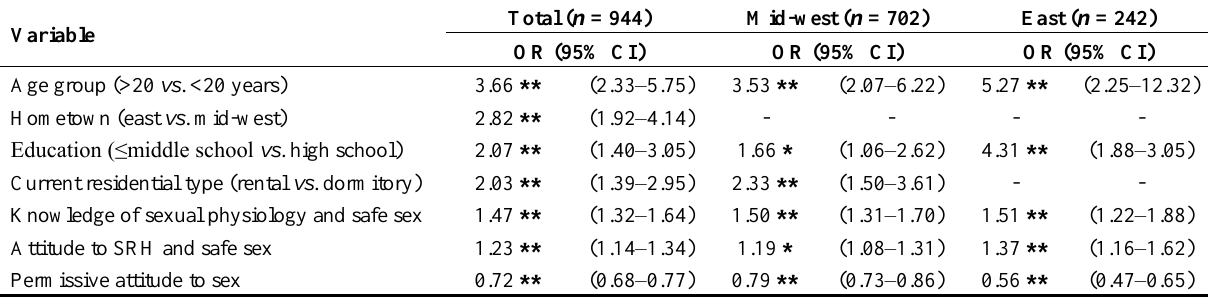
Table 3. Logistic regression models predicting premarital sexual intercourse among unmarried rural-urban female migrants from mid-west and east China ( N =